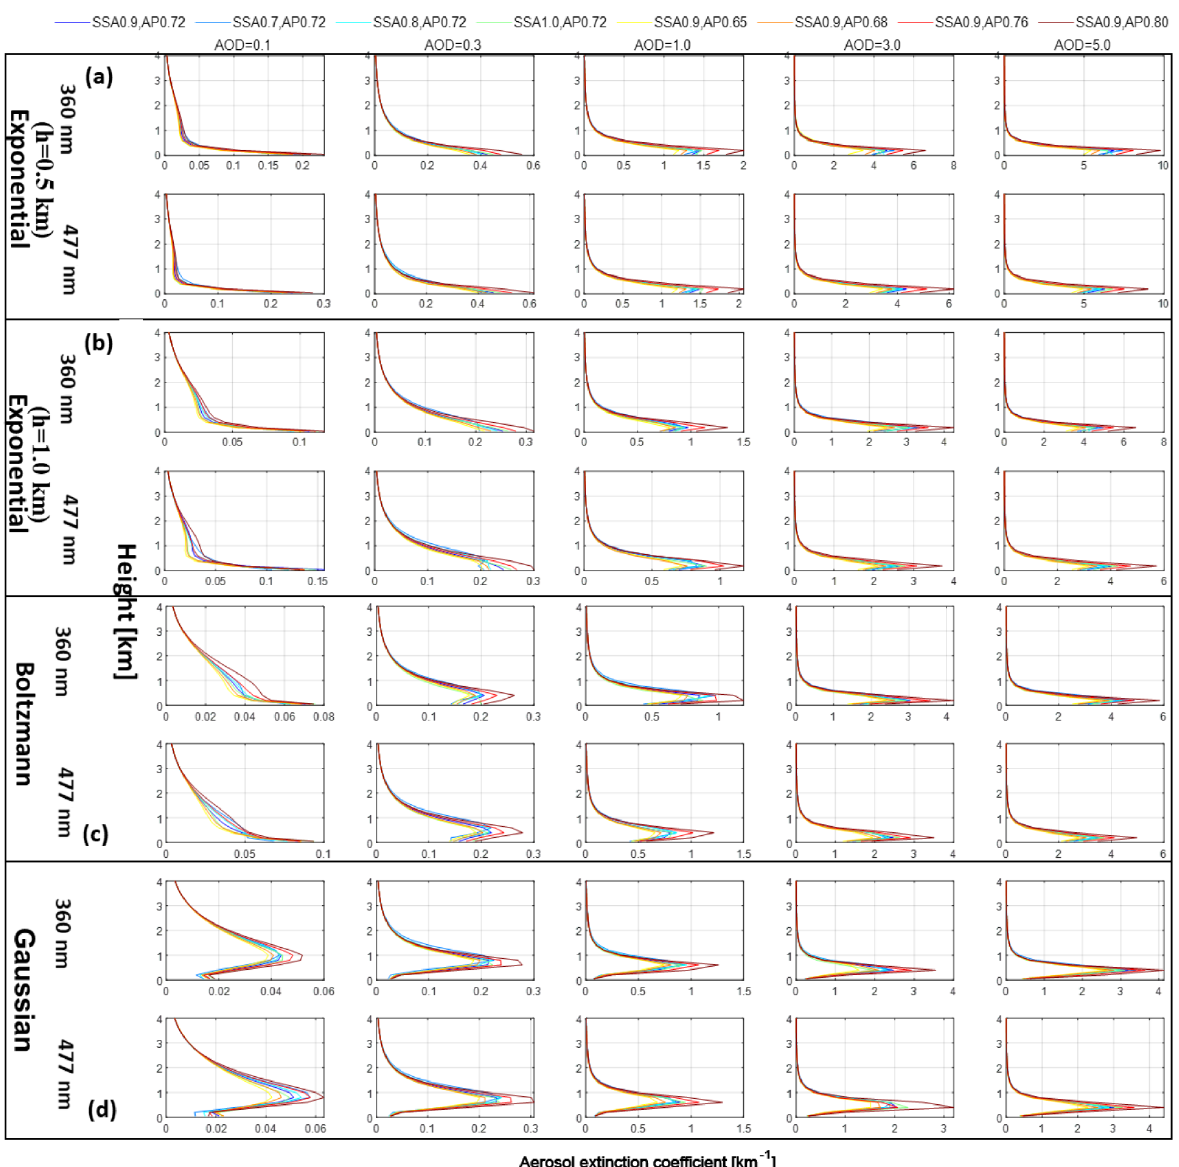
Figure 10. The retrieved profiles using incorrect SSA and AP values from the retrieved profiles with the correct SSA and AP values for (a) exponential shape with h = 0.5km, (b) exponential shape with h = 1.0km, (c) Boltzmann shape, and (d) Gaussian shape. The colors refer to the SSA and AP values shown at the